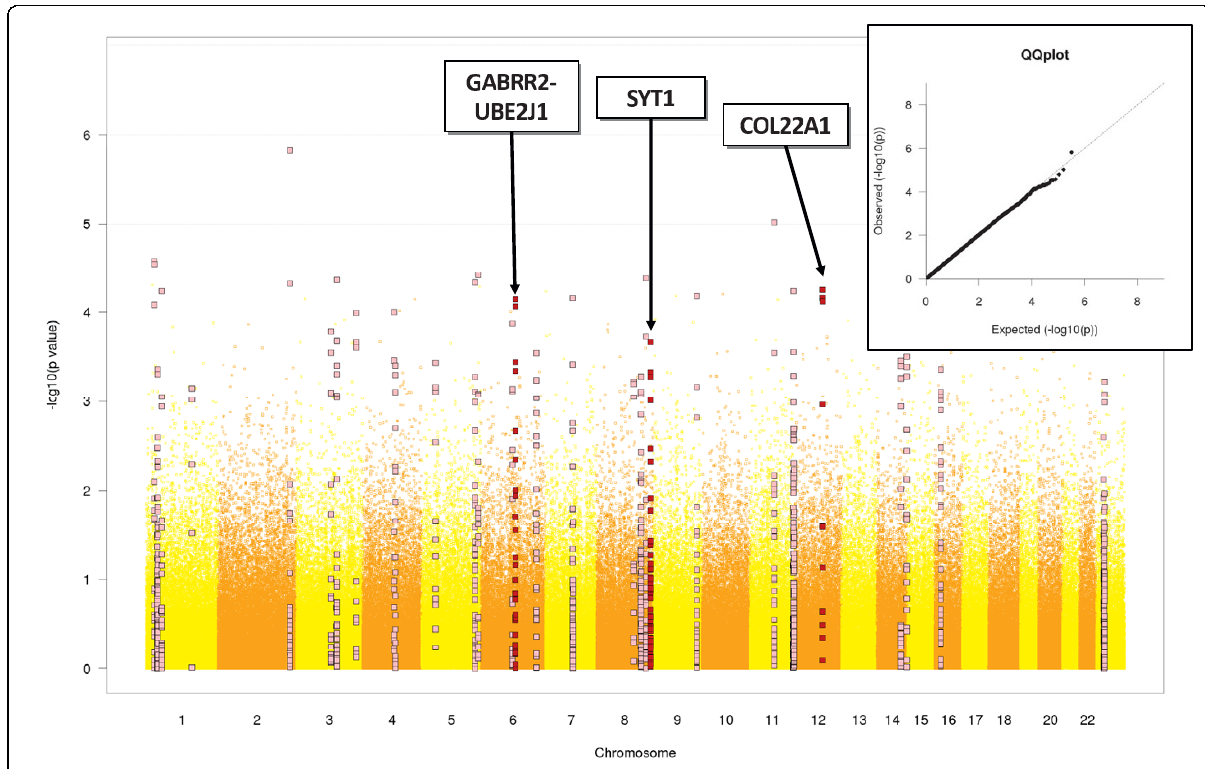
Figure 2 Manhattan plot of -log 10 (p values) from the meta-analysis of five GWA studies . GWA results were combined across all studies by fixed-effects meta-analysis using inverse variance weighting. Square dots indicate SNPs satisfying criteria for selection of candidate regions. SNPs within replicated regions are colored in dark red and SNPs within non-replicated regions in pink. The genomic control factor of l = 1.004, assessed by the quantile-quantile plot in the upper-right panel, indicates that cryptic relatedness and population structure have been modeled